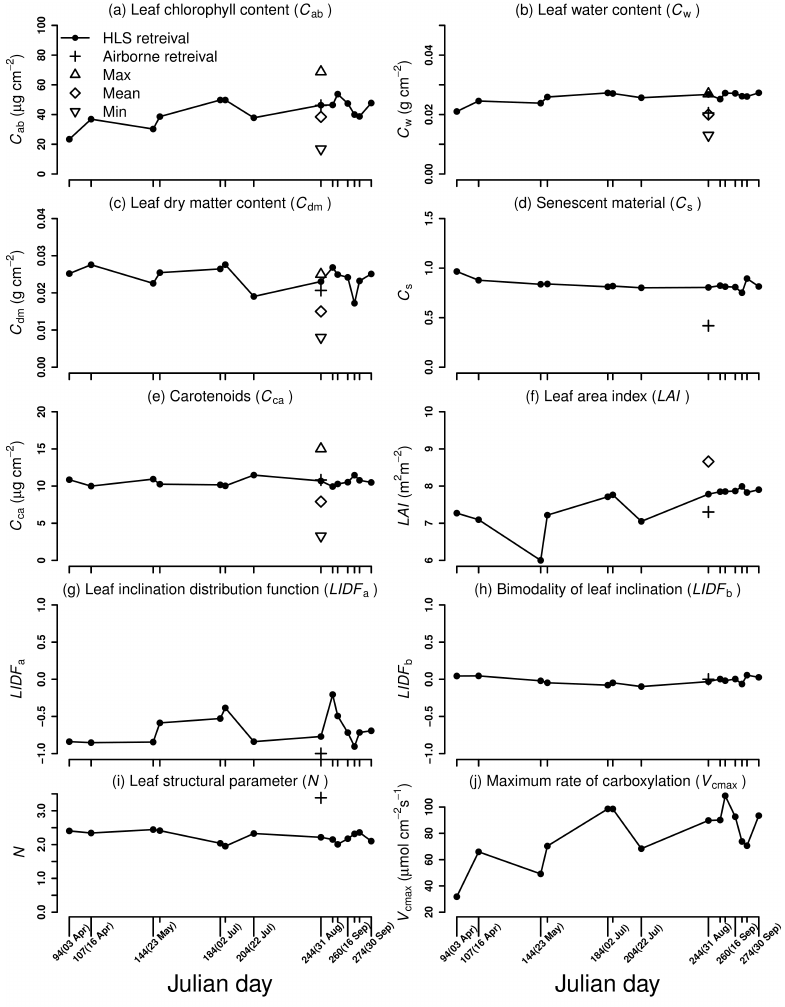
Figure 4. ( a–i ) Retrieved vegetation properties ( C ab , C w , C dm , C s , C ca , LAI , LIDF , and N ); ( j ) maximum rate of carboxylation ( V cmax ) from the available time series of the harmonized Landsat-8 and Sentinel-2 data during the 2016 growing season. Retrievals from the airborne hyperspectral data for one specific acquisition on 31 August are indicated by the plus sign. Wherever field measurements were available, mean values (diamond sign) and minimum–maximum (Min–Max) ranges are indicated. Information about the vegetation properties is given in Table